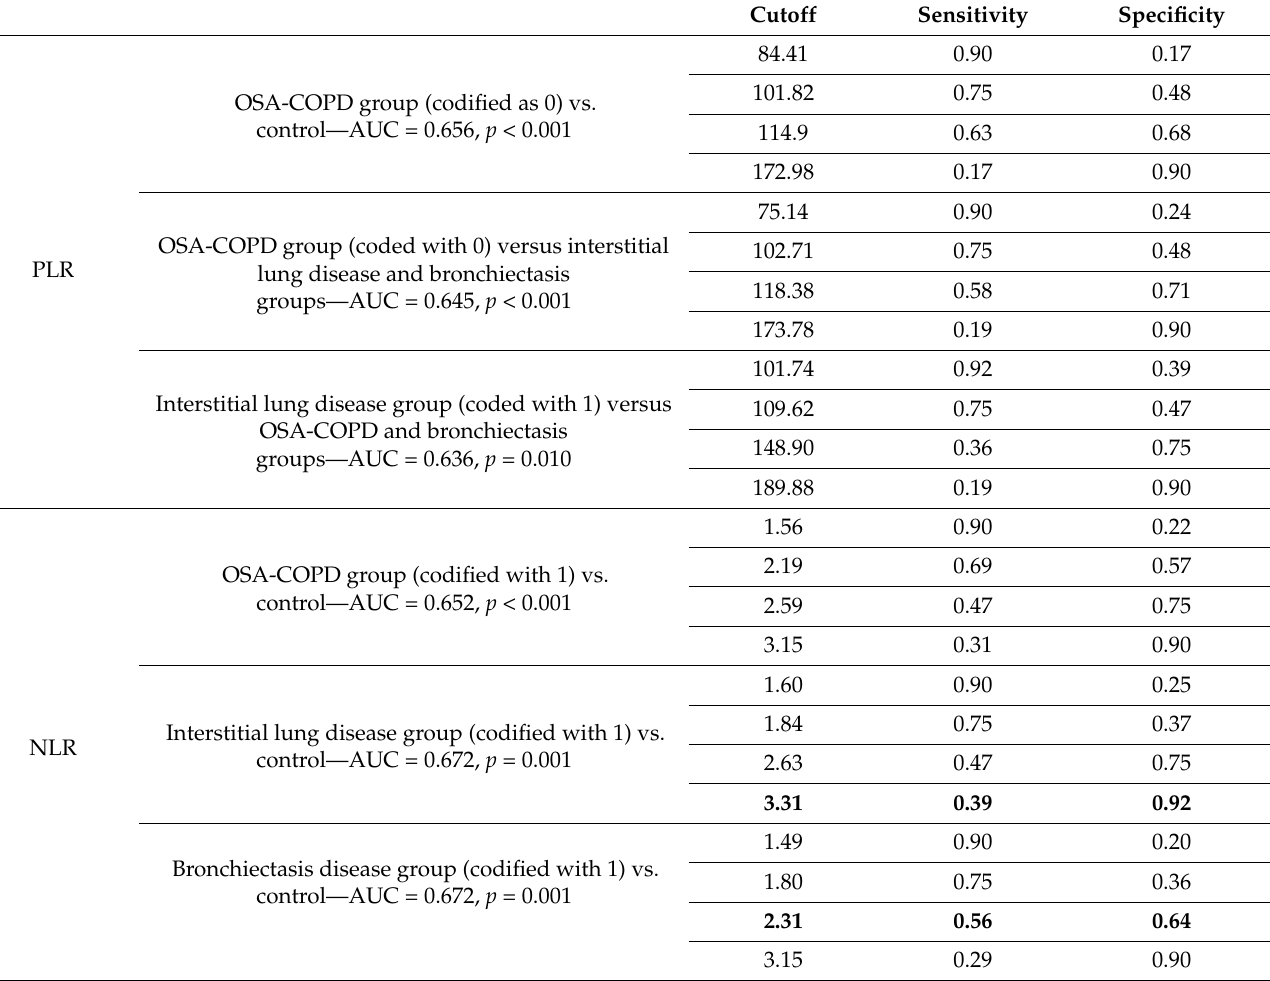
Table 4. Performance of PLR and NLR when we compare chronic respiratory disease. Cutoff Sensitivity